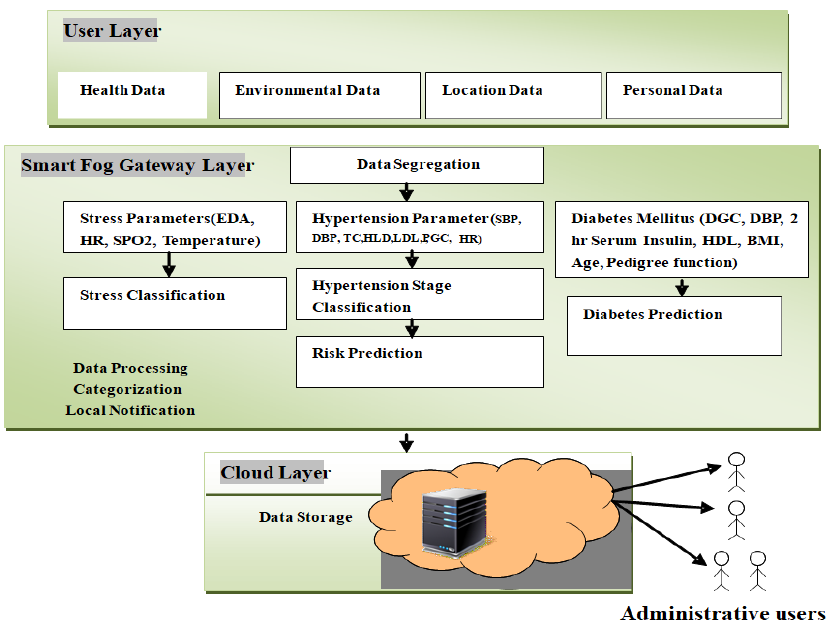
Figure 2. The proposed DeepFog framework has a middle layer that works as a smart gateway, residing between the user and the cloud layer. The user layer is an integration of all smart data